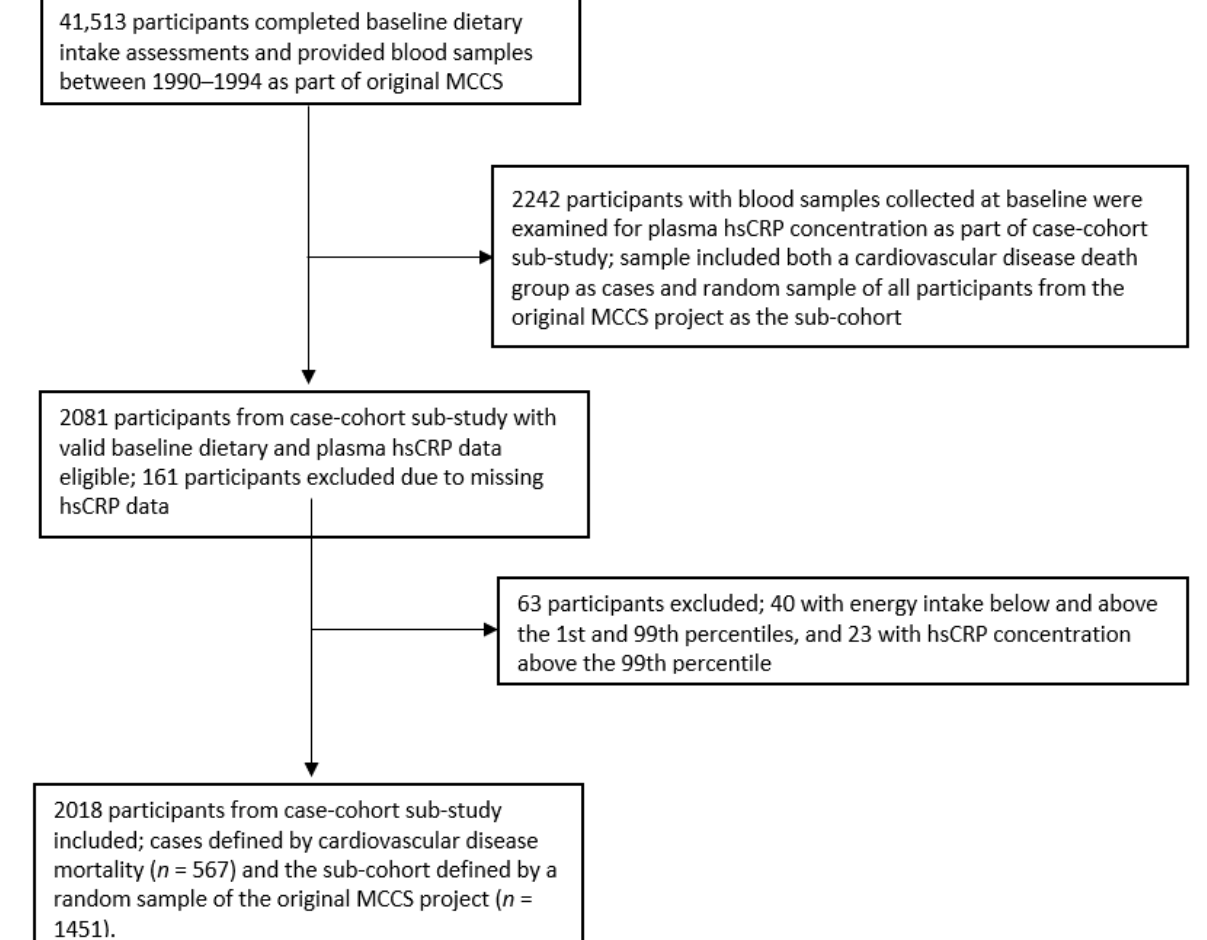
Figure 1. Flow-chart of participant selection. MCCS—Melbourne Collaborative Cohort Study, hsCRP—high-sensitivity C-reactive protein.